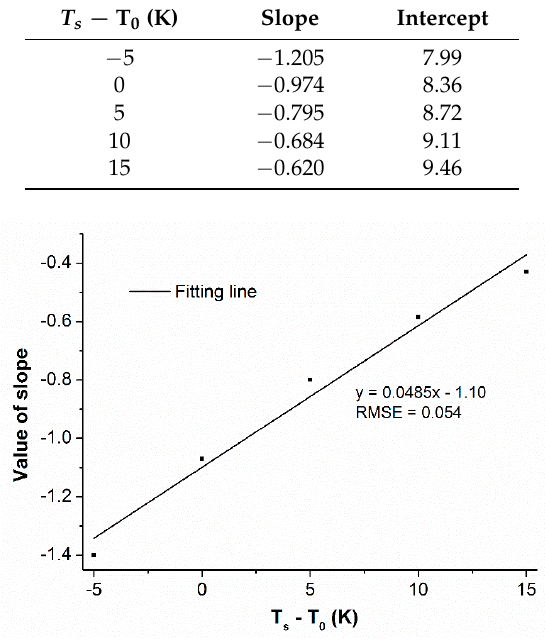
Figure 9. For water vapour content (W) greater than 1 g/cm 2 , the slope of the fitting line between constant C in Equation (1) and W versus the surface-air temperature difference T s − T 0 .